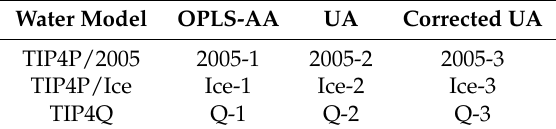
Table 1. Combinations of water and methane models used in this work.